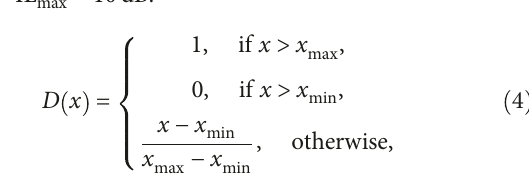
(iv) p 3 = 0 , D 3 IL built as in (4) with IL min = 0 dB and IL = 10 dB . max